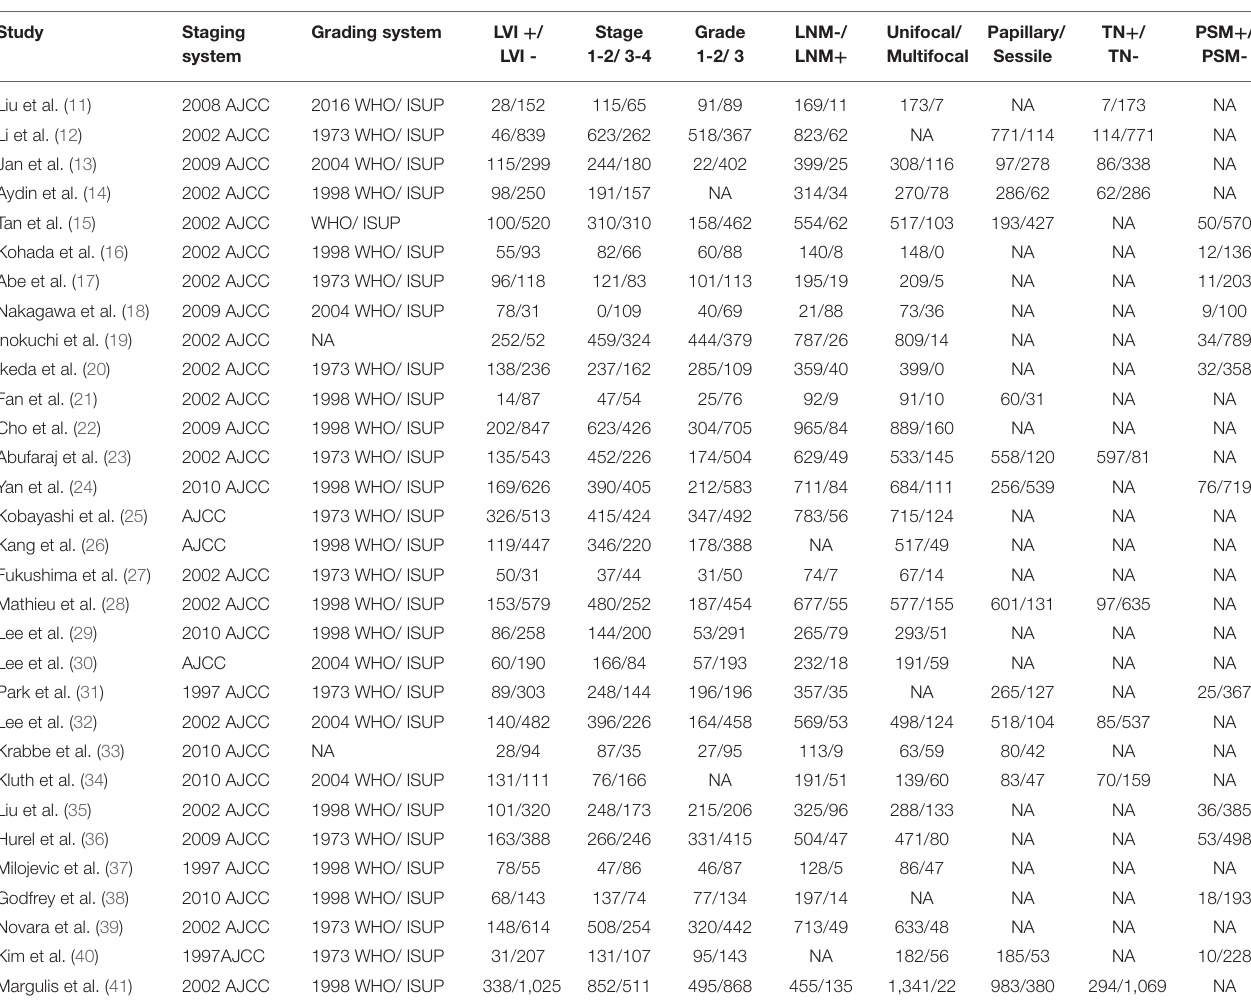
TABLE 2 | Tumor characteristics of the included studies in this